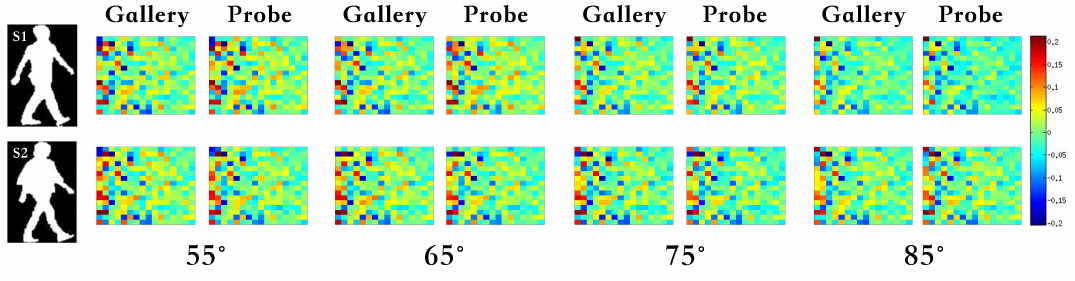
Figure 2. Examples of the 256-dimensional DeepGait after dimension reduction under four observation views (55 ◦ , 65 ◦ , 75 ◦ , 85 ◦ ) . S1 and S2 represent two different subjects, separately. We rearrange the vector as 16 × 16 matrix for the convenience of visualization. Approximately 25% features are non-zero values. Different colors stand for different